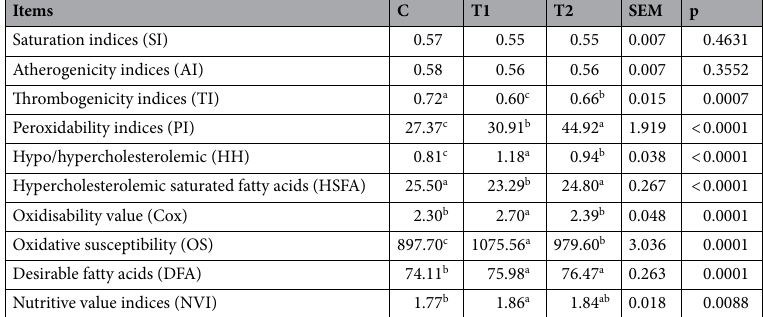
Table 3. Effect of dietary by-products on health-related lipid indices of egg yolks. C control diet, T1 diet supplemented with 9% rapeseed meal with 3% grapeseed meal, T2 diet supplemented with 9% flaxseed meal with 3% sea-buckthorn meal, SEM standard error of the mean, p significance. abc Mean marked with a different superscript letter within each column are significantly different.